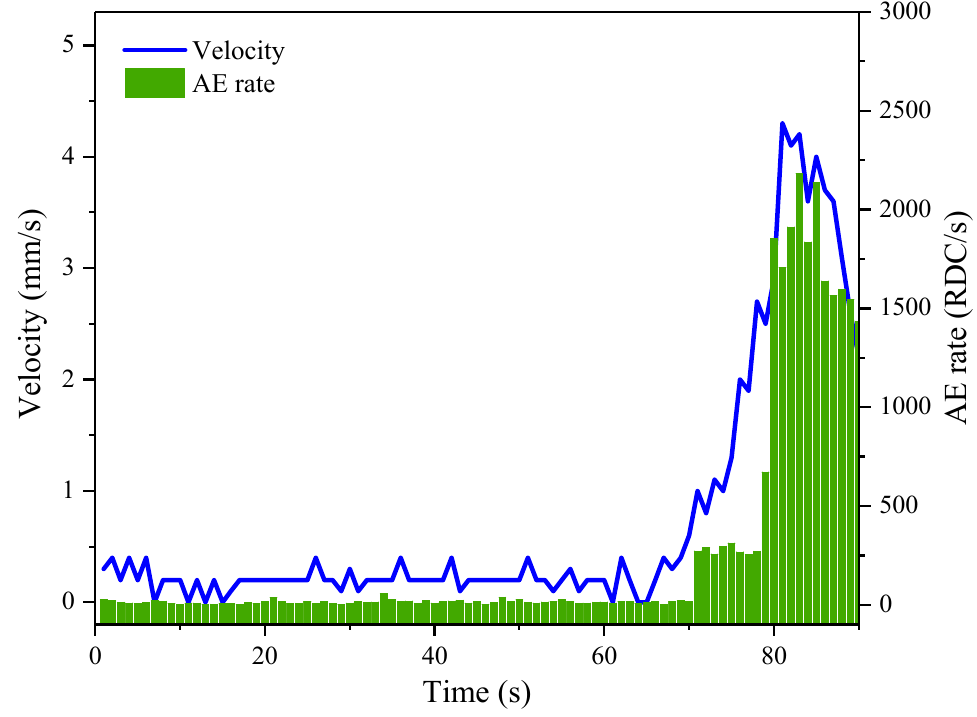
Figure 6. Sliding velocity and ring down count plotted against time. The RDC directly responds to the change of sliding velocity; linear fitting is used to obtain a quantitative relationship. The fitting result is shown in Figure 7. RDC correlates strongly with sliding velocity under linear fitting, and R 2 reaches 0.887. This means that the velocity of landslide can be derived from RDC, which is of great significance to the deformation monitoring of an on-site